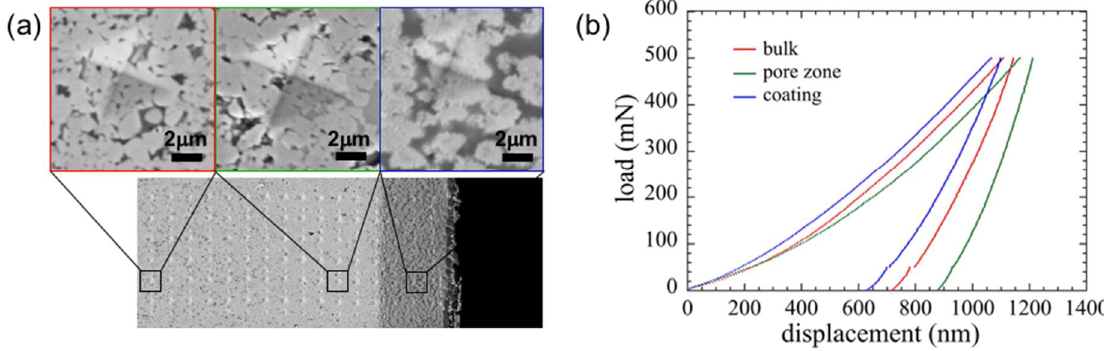
Figure 8. ( a ) Overview of the indentation array, with magnified images of the bulk (left), pore zone (middle), and coating (right). Part ( b ) typical load-displacement curves for each zone.